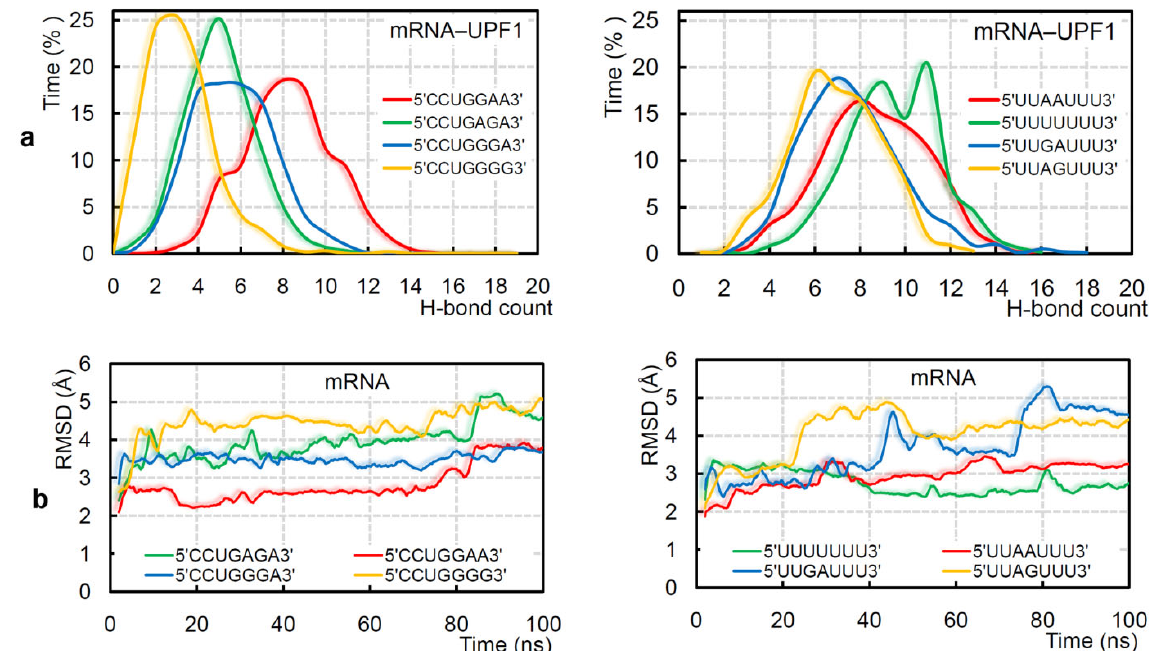
Figure 3. Adopted binding patterns by UPF1 (isoform_1) with different mRNA motifs. ( a ) Frequency of the number of hydrogen bond interactions formed between UPF1 (isoform_1) and different GC ‐ rich (5 ′‐ CCUGGGG ‐ 3 ′ , 5 ′‐ CCUGGGA ‐ 3 ′ , 5 ′‐ CCUGGAA ‐ 3 ′ , and 5 ′‐ CCUGAGA ‐ 3 ′ ) or AU ‐ rich (5 ′‐ UUUUUUU ‐ 3 ′ , 5 ′‐ UUAAUUU ‐ 3 ′ , 5 ′‐ UUAGUUU ‐ 3 ′ , and 5 ′‐ UUGAUUU ‐ 3 ′ ) motifs. ( b ) Root ‐ mean ‐ square deviation (RMSD) of atomic positions (excluding hydrogen atoms) for the GC ‐ and AU ‐ rich mRNA motifs computed in the presence of the UPF1 protein.